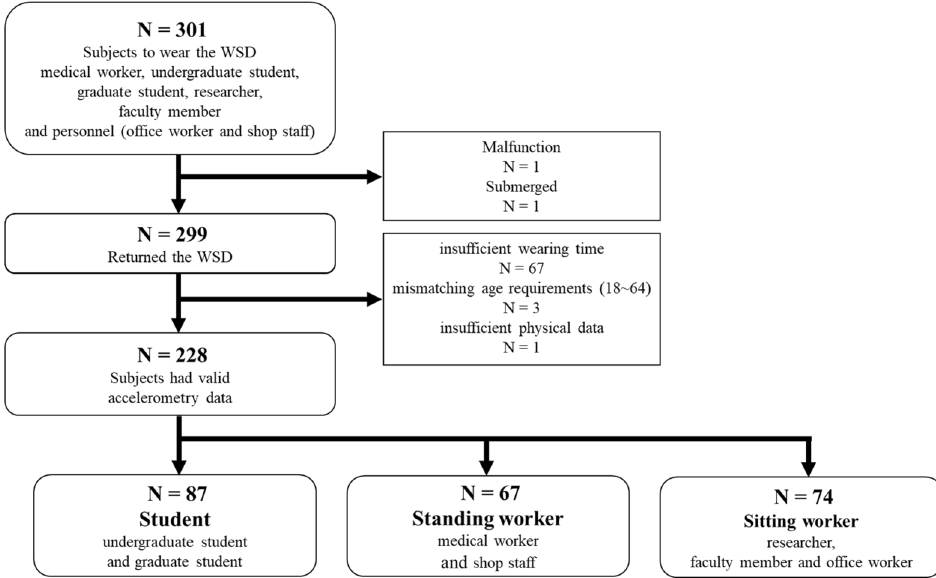
Figure 1. Flow chart showing the selection process of participants in the present study. WSD wearable sensor